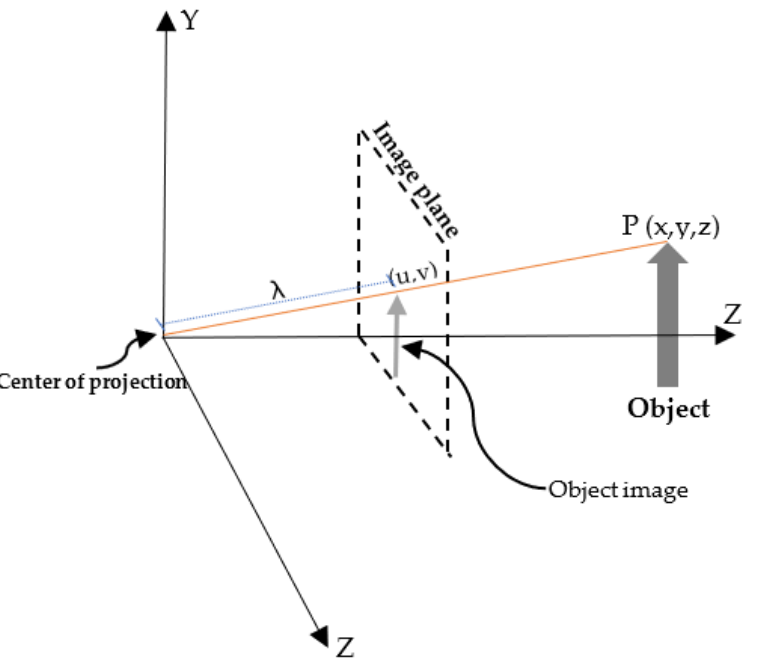
Figure 2. Pinhole camera object representation. Adapted from [16].